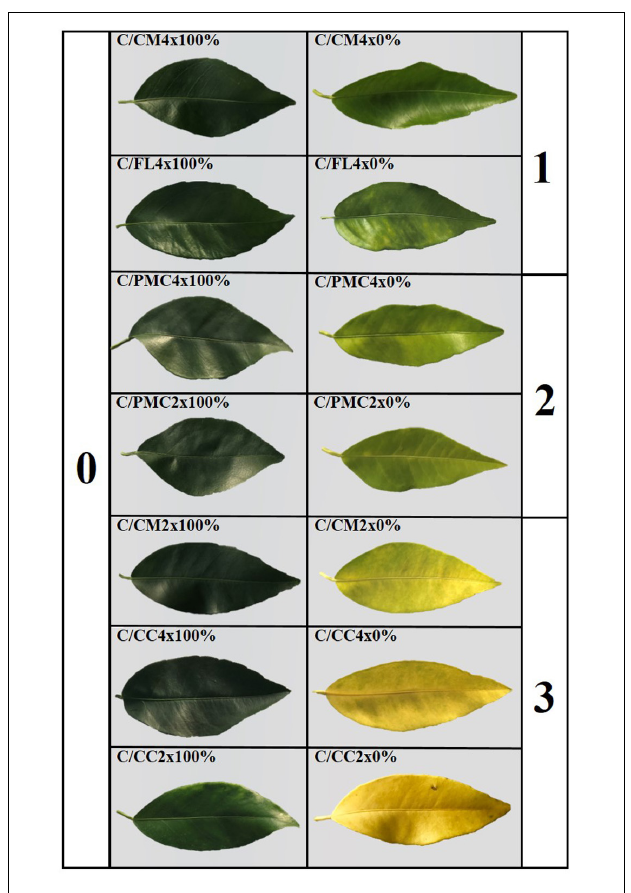
FIGURE 1 | Assessment of leaf damages after 210 days of total nutrient deficiency (0%) on clementine trees grafted onto the seven rootstocks compared to controls (100%). Genotypes are ranked based on the leaf symptoms from the lesser affected (1) to the more affected